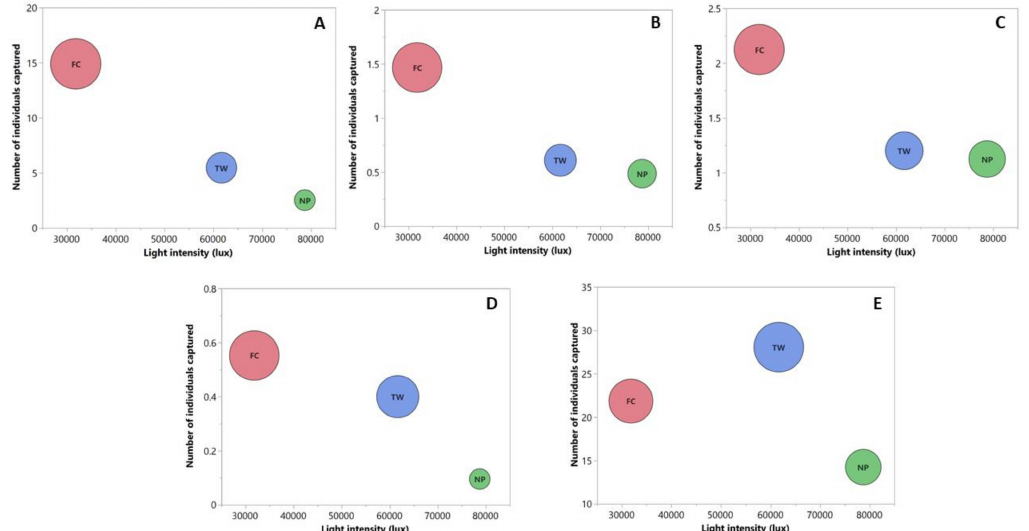
Figure 4. Relationship between LW vector abundance and light intensity levels in LW–affected avocado orchards during a four-month period (March 2018–June 2018). Bubbles of different sizes represent the abundance of beetles. ( A ) Xylosandrus crassiusculus , ( B ) Xyleborus affinis , ( C ) Xyleborus volvulus , ( D ) Xyleborus bispinatus , and ( E ) Xyleborinus saxesenii . (Note different scales on the y-axis). FC = Full canopy; TW = Topworked; NP = New